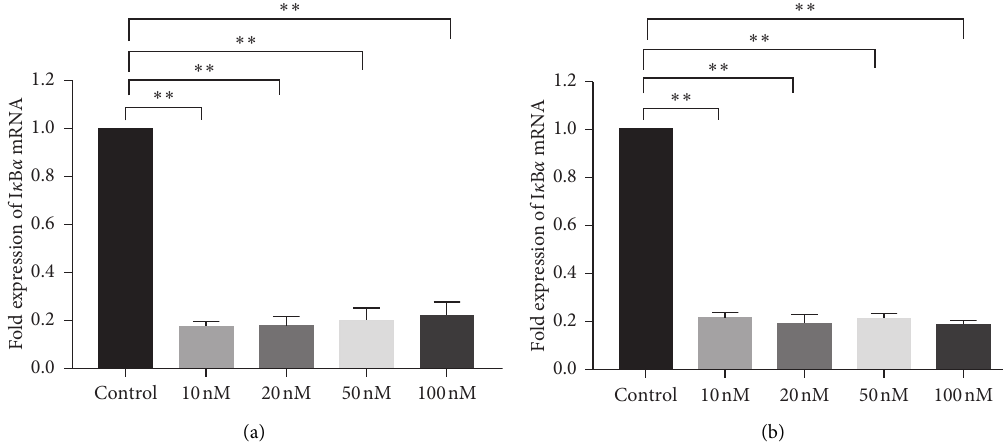
Figure 8: Relative expression of I κ B α mRNA after transfection of different concentrations of I κ B α -siRNA ranged from 10nM to 100nM. The control group was only transfected with transfection reagent. (a) The mRNA expression of I κ B α in each experimental group was significantly lower than that in the reagent transfection group ( P < 0 . 01). However, no statistically significant associations were observed among different concentration groups ranged from 10nM to 100 nM in CM cells. (b) The mRNA expression of I κ B α in each experimental group was significantly lower than that in the reagent transfection group ( P < 0 . 01). However, no statistically significant associations were observed among different concentration groups ranged from 10 nM to 100nM in TM cells. ∗ P < 0 . 05; ∗∗ p < 0 .